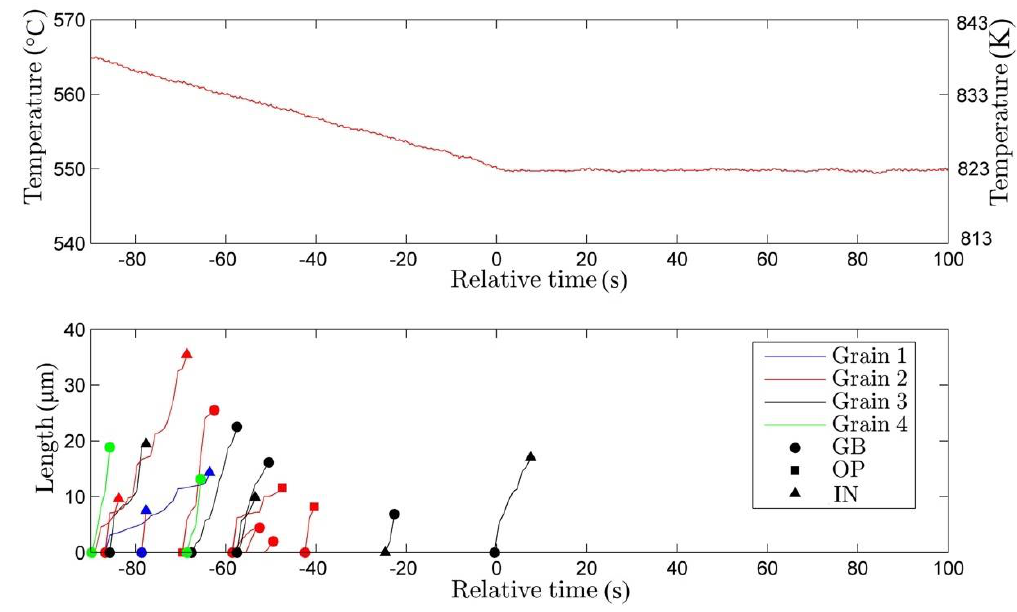
Figure 10. Temperature versus time and temporal plate growth sequence of bainitic ferrite plates in Fe-0.2C-1.5Mn-2.0Cr during isothermal holding treatment at 823 K (550 °C).